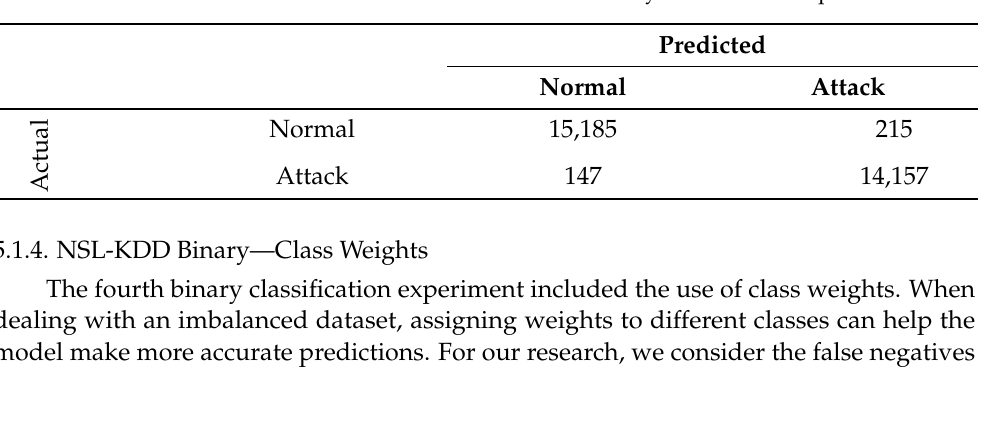
Table 8. Confusion matrix for NSL-KDD “reduced features” binary classification